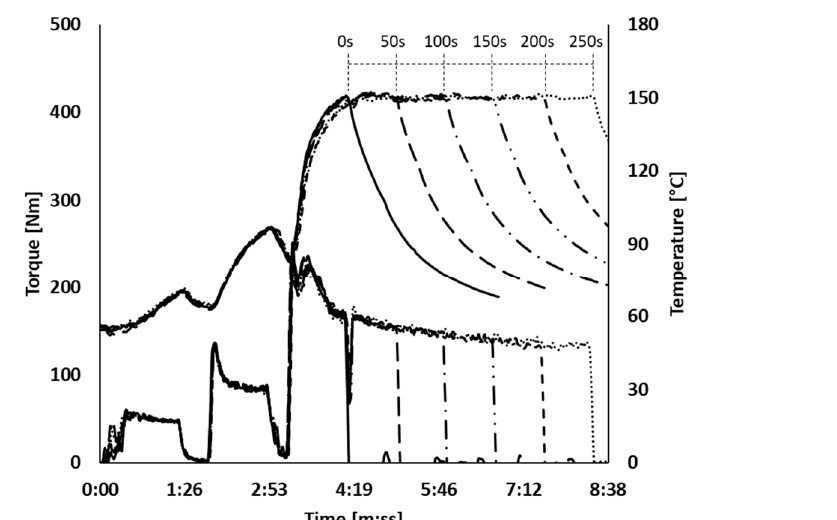
Figure 1. Mixing fingerprints of mixing procedure A; ( ): 120 °C; ( ): 130 °C; ( ): 140 °C;